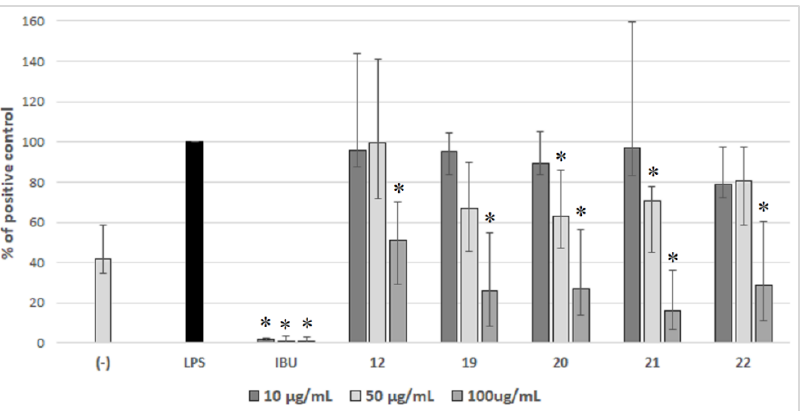
Figure 2. The effect of compounds 12 , 19 – 22 and IBU on the LPS-induced production of TNF- α in PBMC cultures (the results are shown as percentage of positive control (LPS alone), with values expressed as medians from previous independent experiments and confidence intervals); * indicates a significant difference compared to the positive control (LPS alone) at p < 0.05.